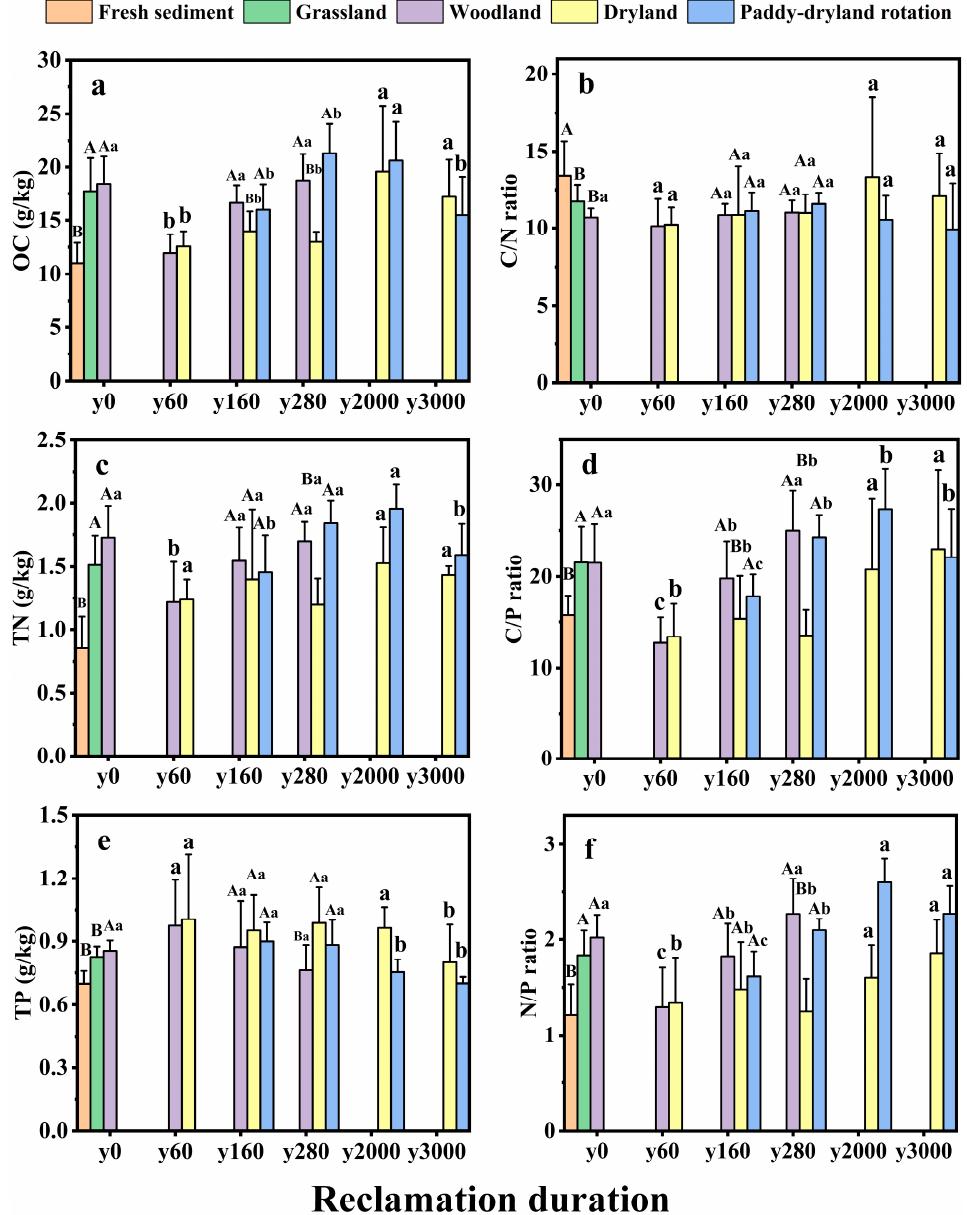
Figure 4. OC, TN, and TP contents and ratios along the chronosequence over different land uses. ( a ) Organic carbon; ( b ) C/N ratio; ( c ) total nitrogen; ( d ) C/P ratio; ( e ) total phosphorus; and ( f ) N/P ratio. Different uppercase letters indicate that means are different at p < 0.05 among land uses at the same reclamation stage. Different lowercase letters indicate means are different among the same land use across reclamation